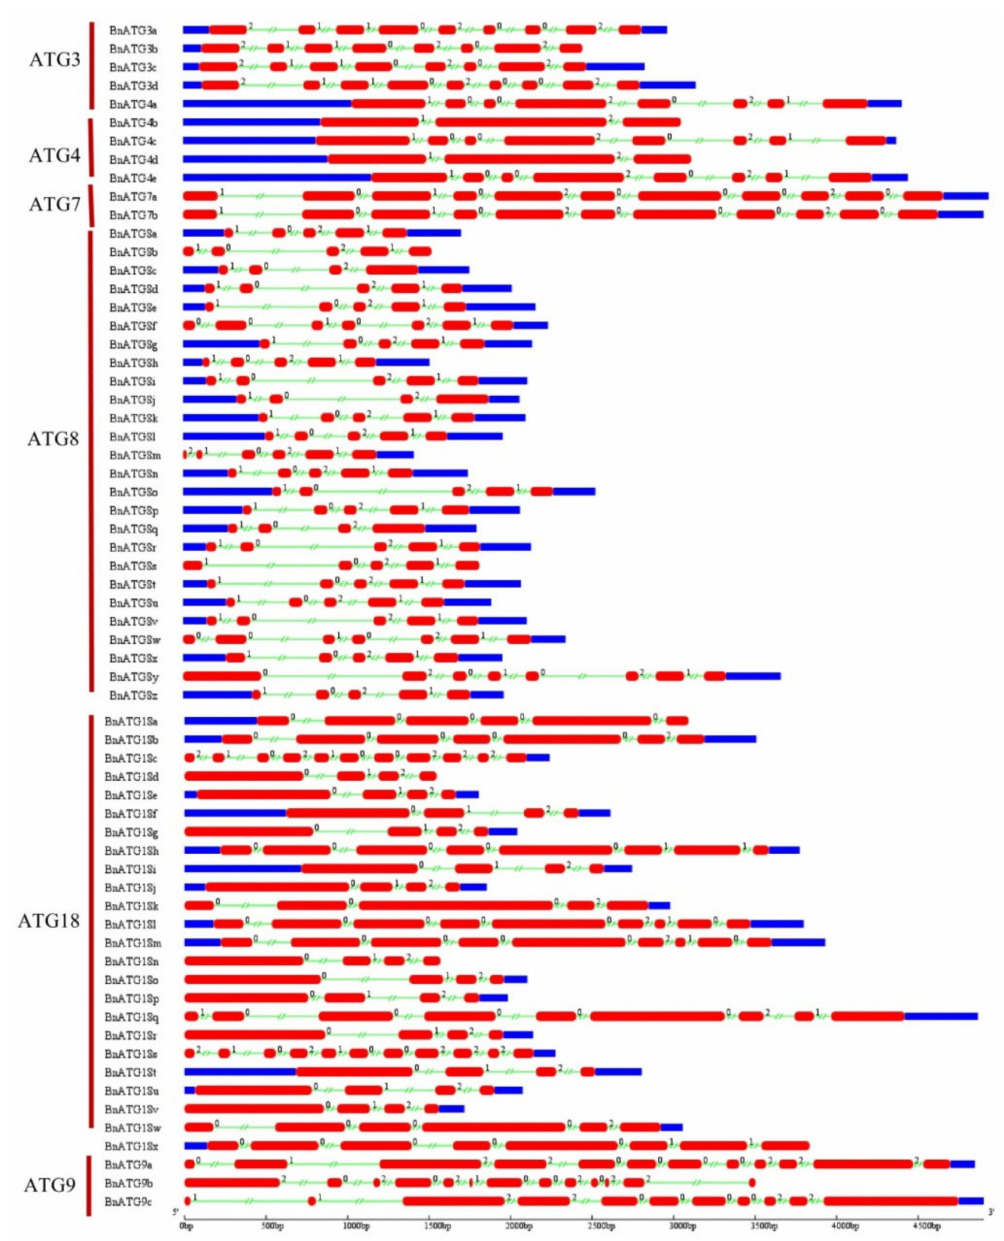
Figure 5. The exon–intron structure of ATG3–4, ATG7–9, VPS15 , VPS34 , VTI12 , and TOR in B. napus . Exons and introns were represented by red boxes and green lines, respectively. The exon–intron structure of the BnATGs was determined using a gene structure display server